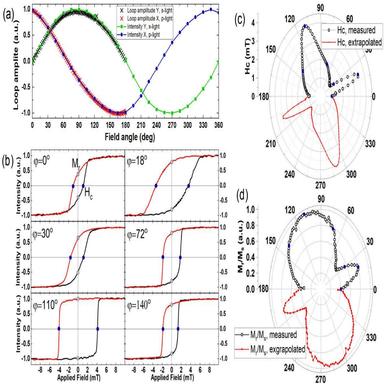
(a) Absolute difference of the image grey levels in oppositely saturated states (I+ − I− ) for orthogonal light incidences, derived from hysteresis loops with the field being swept along fixed direction at angles from 0◦ to 180◦ (black and red crosses). The data points in the range of 0 − 360◦ are obtained during the rotation of the external field of 15 mT (green and blue circles, the solid lines are guides to the eye). (b) Magnetisation reversal loops reconstructed for selected field directions. Blue point